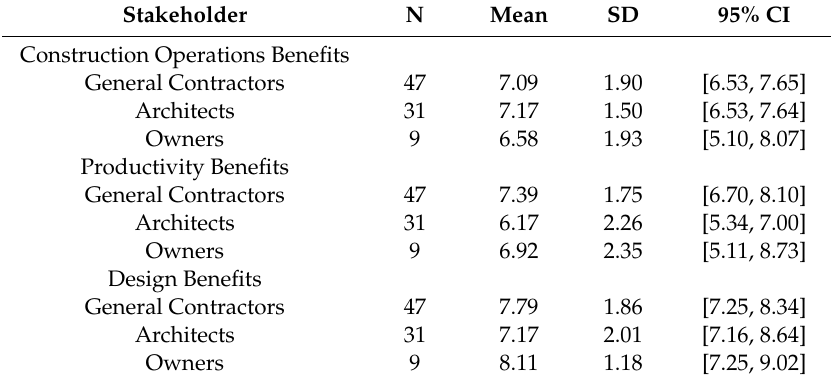
Descriptive Statistics by Stakeholder: Construction Operations-, Productivity- and Design-Related Realized Benefits